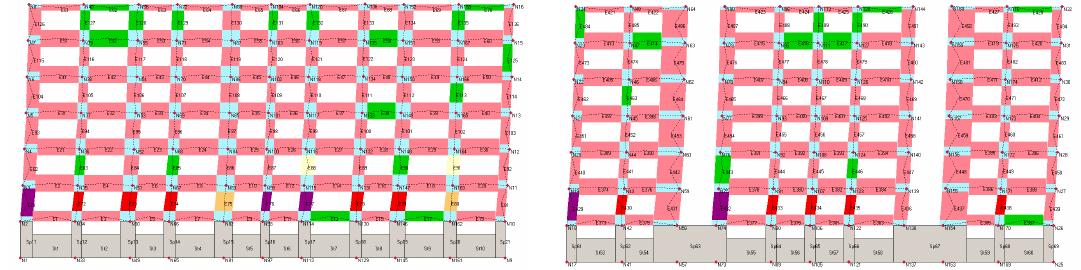
Figure 14. Façade walls damage of the original structure after exposure to PGA = 0.1 g.